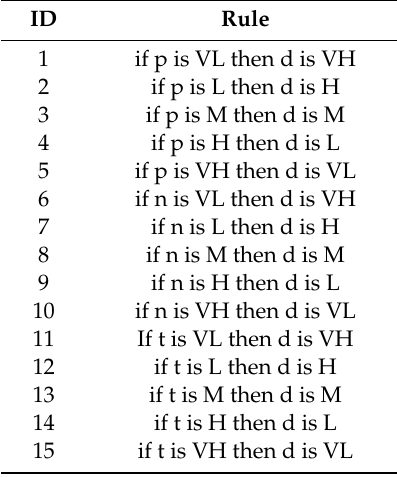
Table 4. Fuzzy rule base for mean Sauter diameter of the grinding